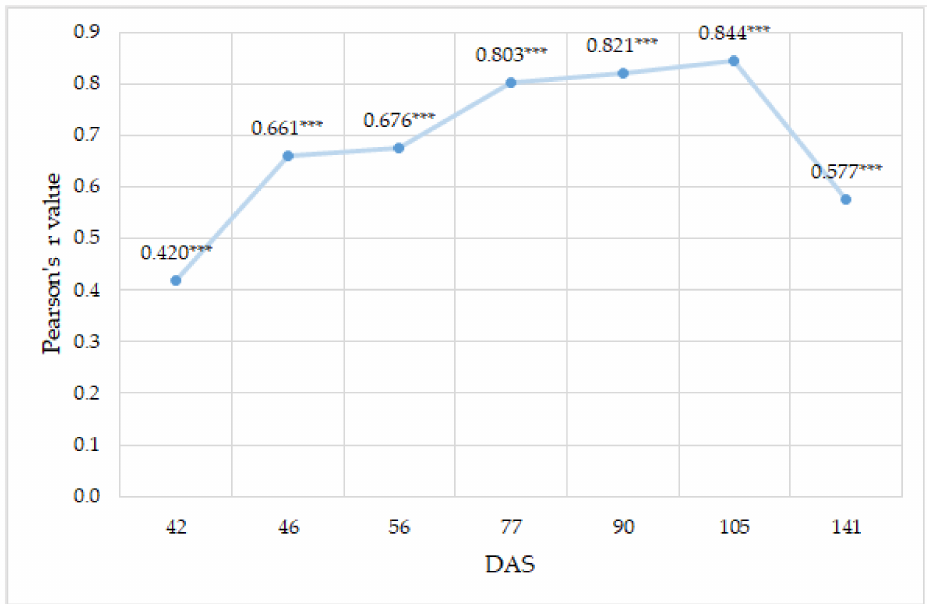
Figure 5. Pearson correlation coefficient (r) dynamic among NDVI UAV and yield t ha − 1 (2021, Debrecen). Note: ***. Correlation is significant at the 0.001 level.